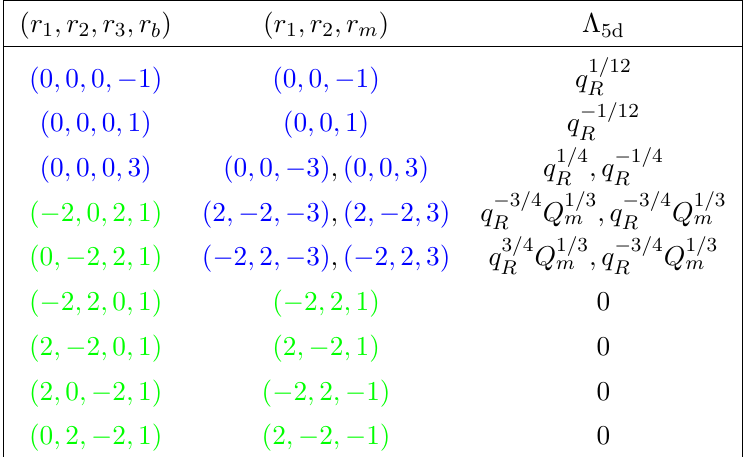
for the SU(3) model. Unity 5d